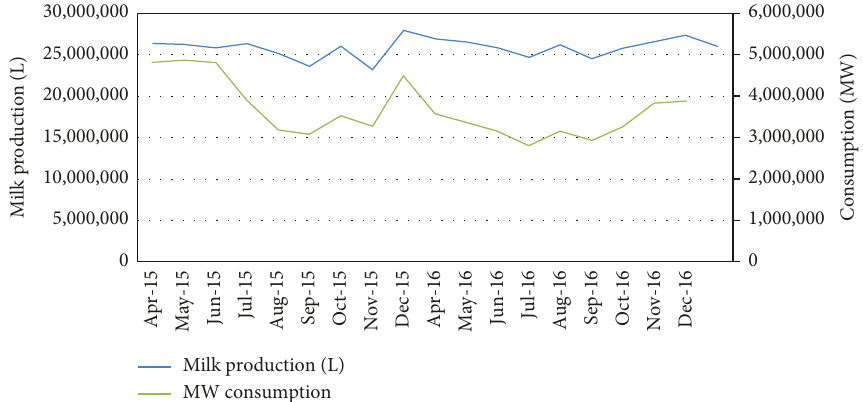
Figure 3: Graphical representation of megawatt consumption (MW) during the 8-month study period, comparing 2015 (+4 ° C) and 2016 ( 4 ° −